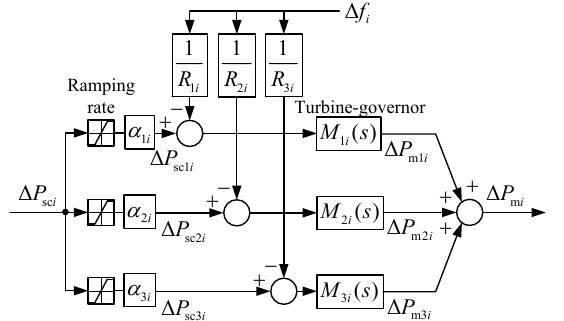
Figure 8. Schematic block diagram representation of the CA i without the INP and the CBRR.